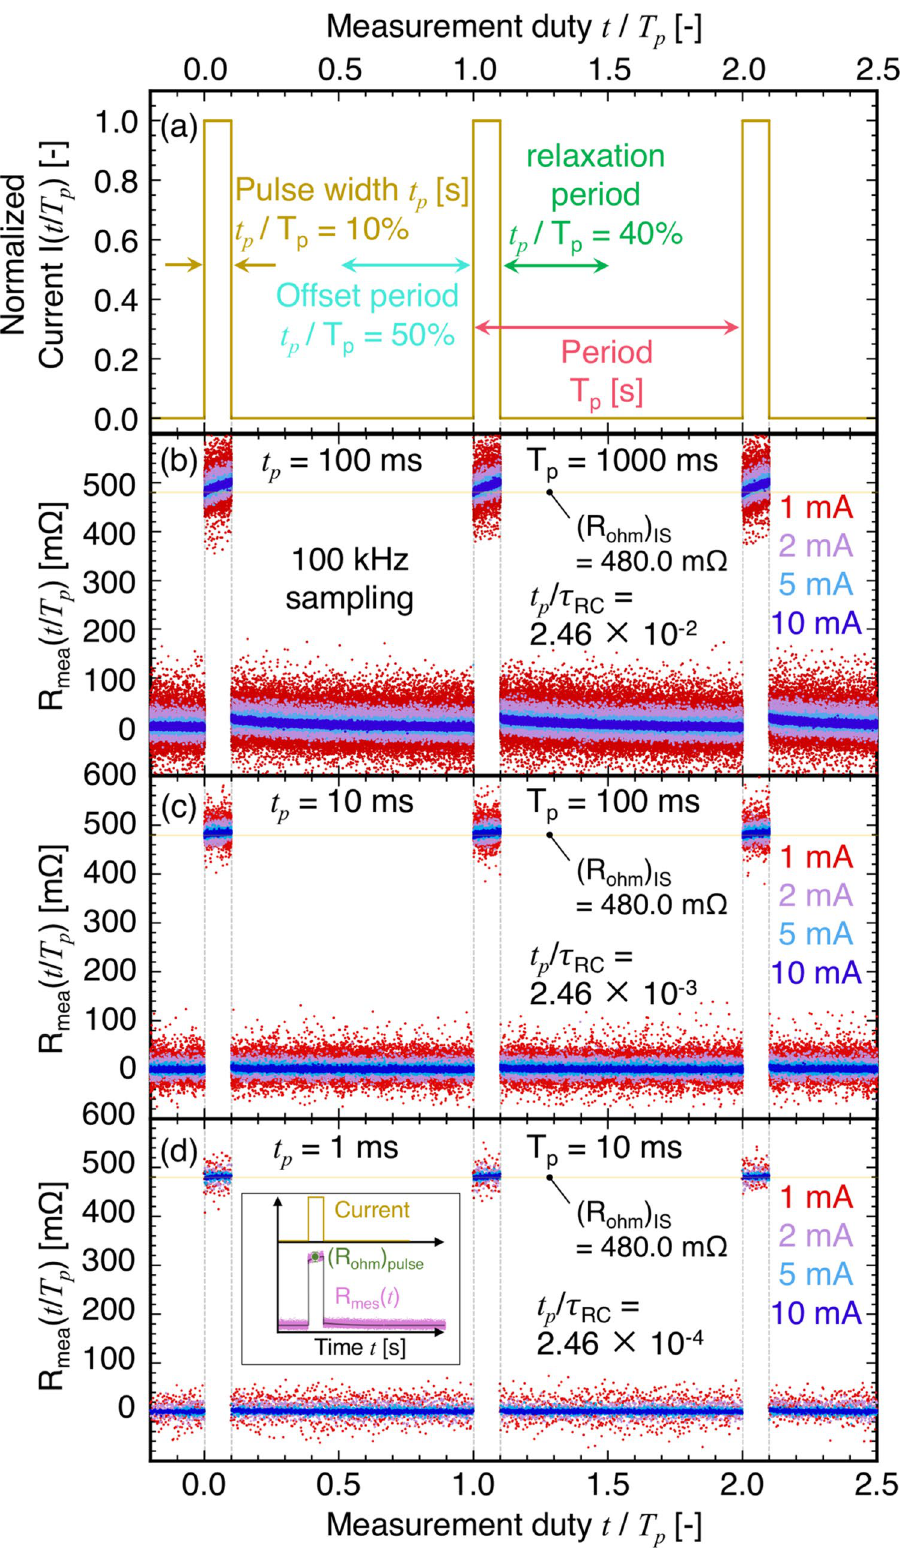
Figure 5. Normalized time dependence of ( a ) pulse current I ( t / T p ), measured resistance R mea ( t / T p ) at ( b ) t p = 100 ms and T p = 1000 ms, ( c ) t p = 10 ms and T p = 100 ms, ( d ) t p = 1 ms and T p = 10 ms for each pulse DC (1–10 mA ) by a DAQ system (100 kHz sampling rate), respectively. 10%, 40%, and 50% of the entire pulse period T p in ( a ) correspond to the pulse DC width t p , relaxation period to remove the temperature gradient (or difference) on the TEs of the TM, and offset period to determine the zero voltage for the next measurement, respectively. The inset in ( d ) shows how ( R ohm ) pulse can be estimated from obtained